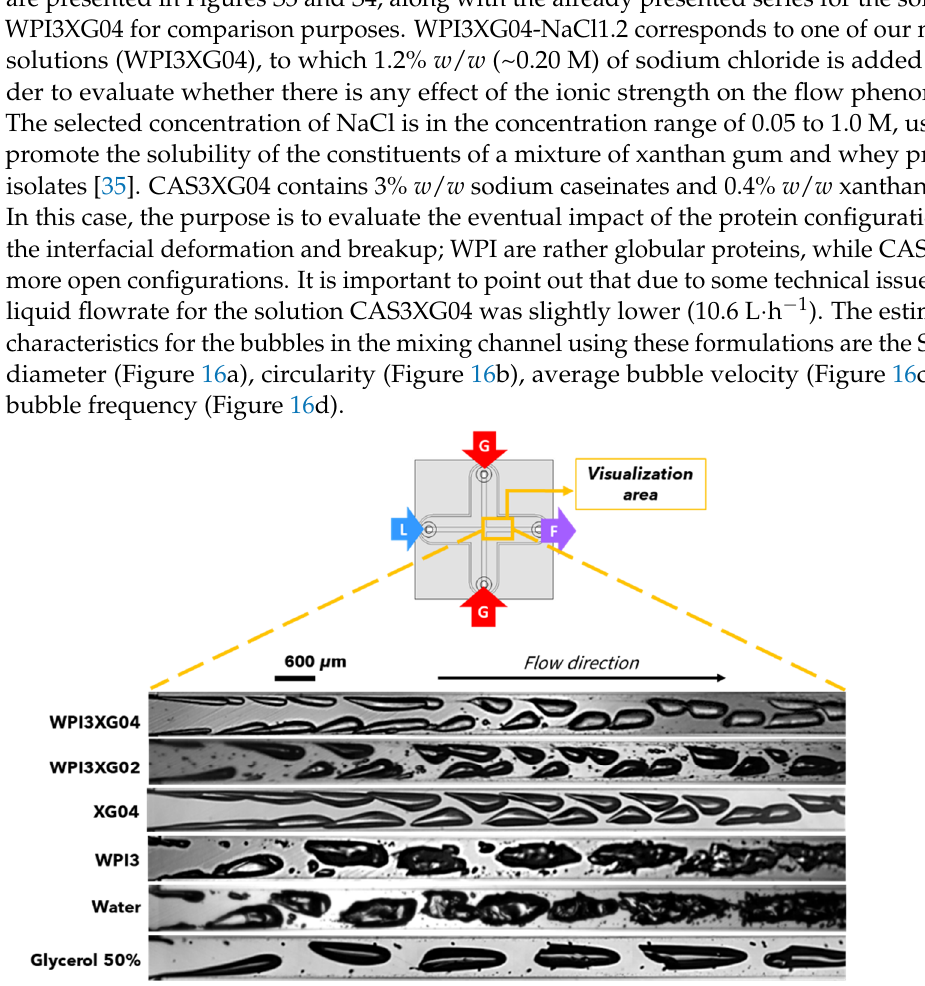
Figure 16. Properties of bubbles flowing through several liquid bases inside the mixing channel of the device CX600 at Q vL = 11 L.h −1 -Q mG = 21.6 g.h −1 ( a ) Sauter diameter. ( b ) Circularity. ( c ) Average bubble speed. ( d ) Bubbling frequency. The liquid flowrate for CAS3XG04 was slightly lower (con- ditions for CAS3XG04 were Q vL = 10.6 L.h −1 - Q mG = 21.6 g.h −1 ).